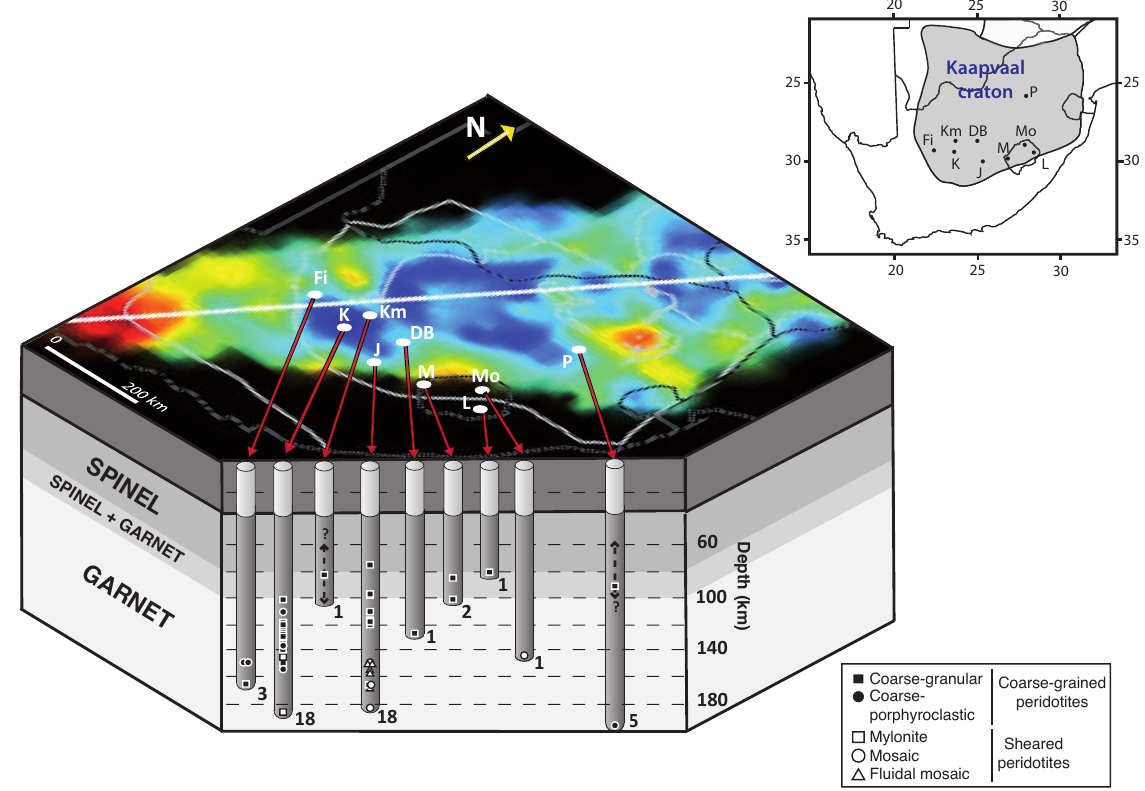
Fig. 1. Sketch displaying the location of the sampled kimberlitic pipes as well as the samples’ depths and microstructures (after Baptiste et al., 2012) relatively to the S wave tomography model of Fouch et al. (2004a) at 150km. Fi: Finsch, K: Kimberley, Km: Kamfersdam, J: Jagersfontein, DB: De Beers, M: Monastery, Mo: Mothae, L: Lentseng, P: